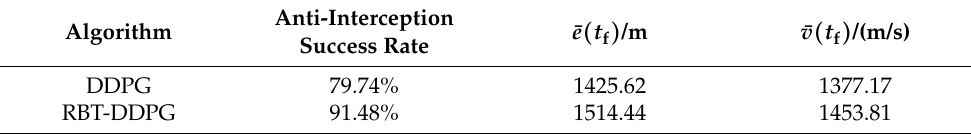
Table 3. Statistical